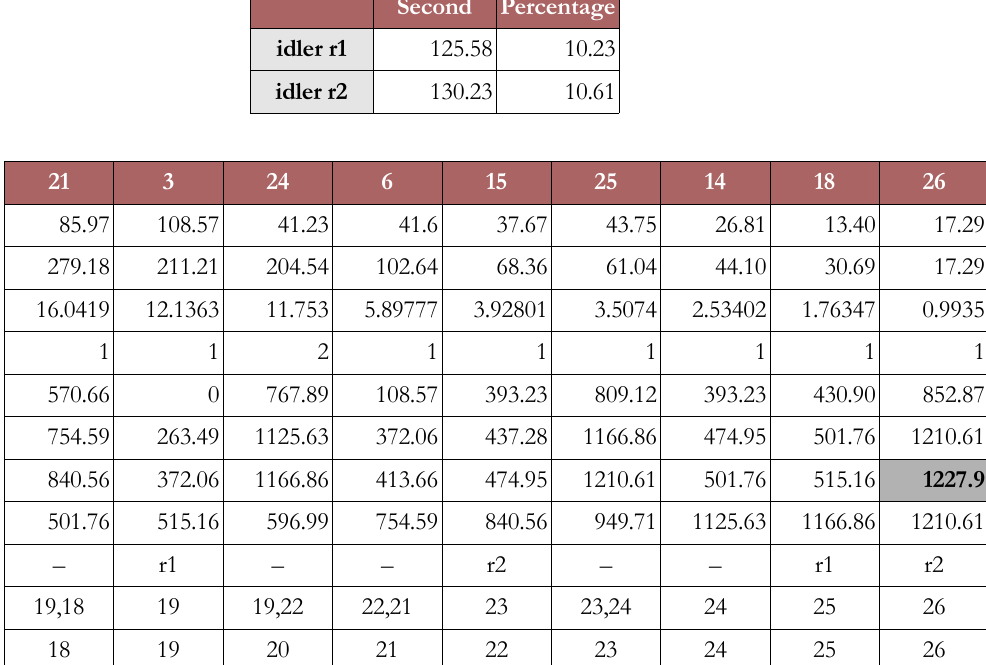
Table 12. ACTRES Scheduling, Rmax = 2, n(r) = 2 (Scenario